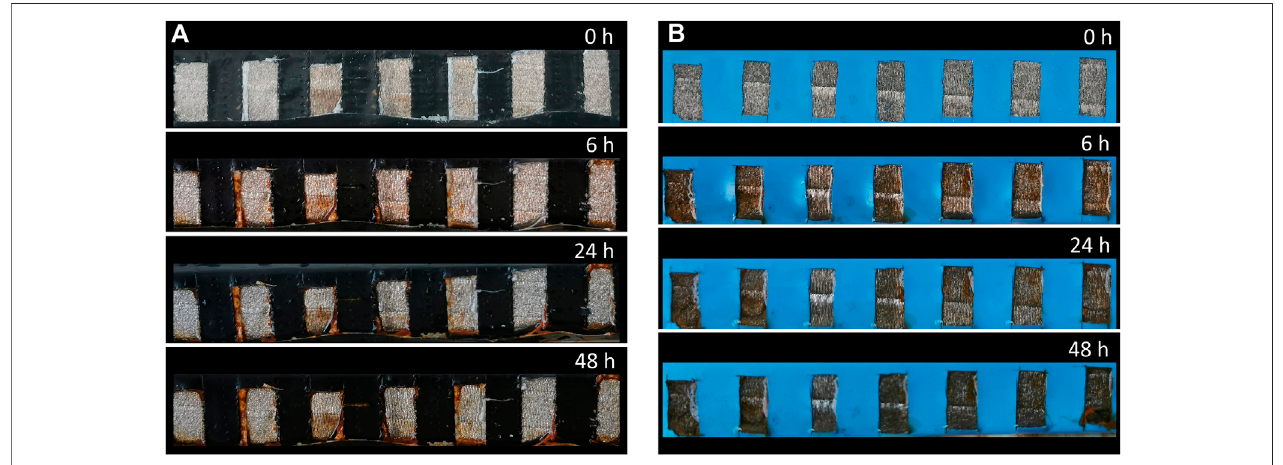
FIGURE 7 | Photos of corrosion test samples after 0, 6, 24, and 48 h (A) represent the Cantor alloy coatings, while (B) represent AlCrMnFeNi.